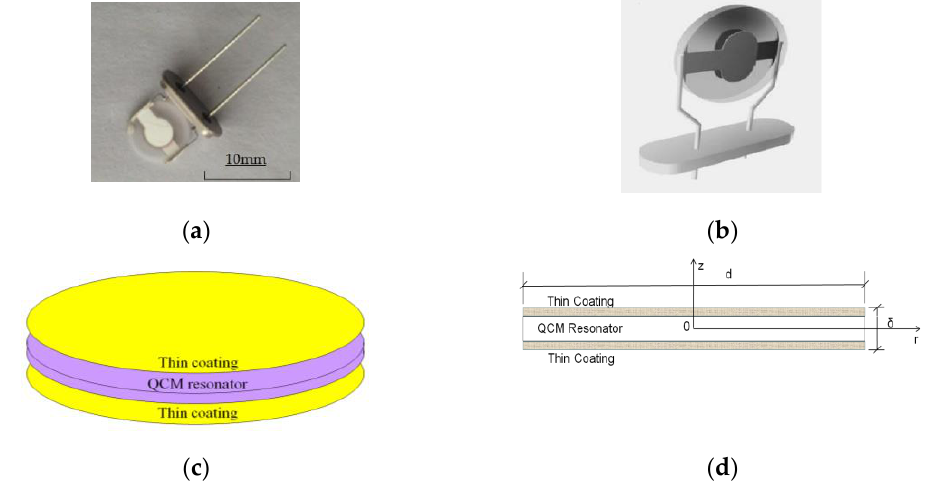
Figure 1. ( a ) Photo of the sensor; ( b ) structure chart of the sensor; ( c ) schematic diagram of the sensor; ( d ) diameter drawing of the sensor.